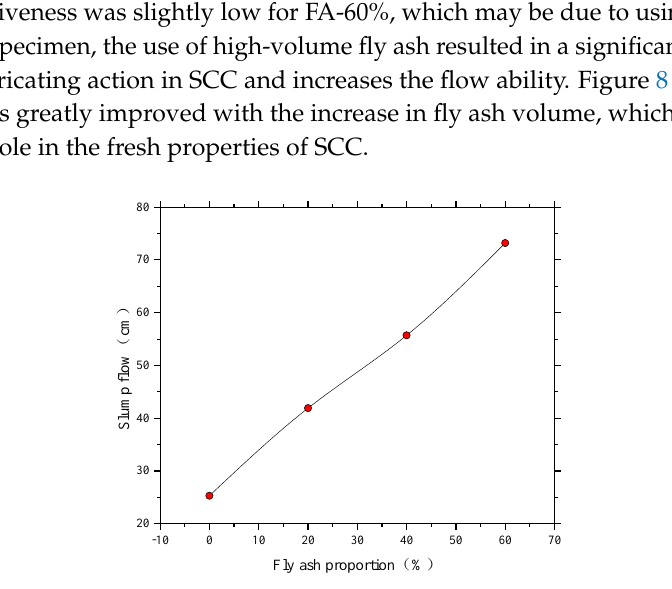
Figure 8. Effect of fly ash proportion on the slump flow.